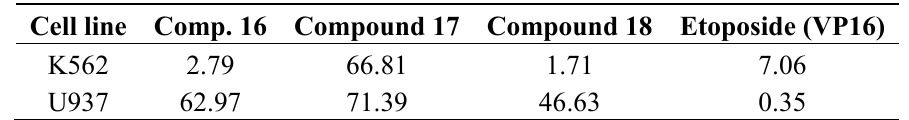
Table 3. IC values (µM) a obtained when K562 and U937 cells were treated with compounds 50 16 – 18 and positive control etoposide (VP16).